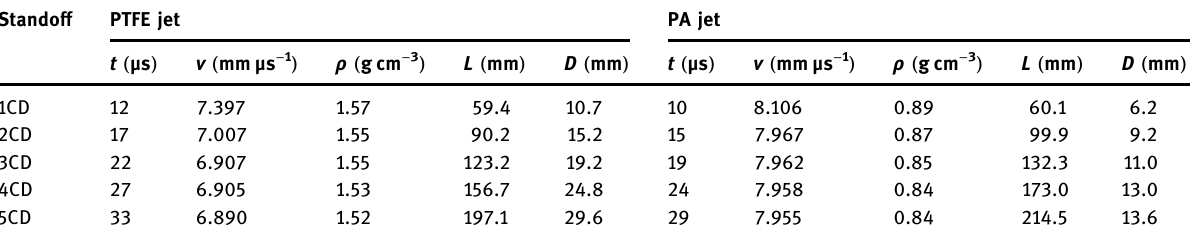
Table 5: Performance parameters of two polymer expansive jets at di ff erent stando ff s Stando ff PTFE jet